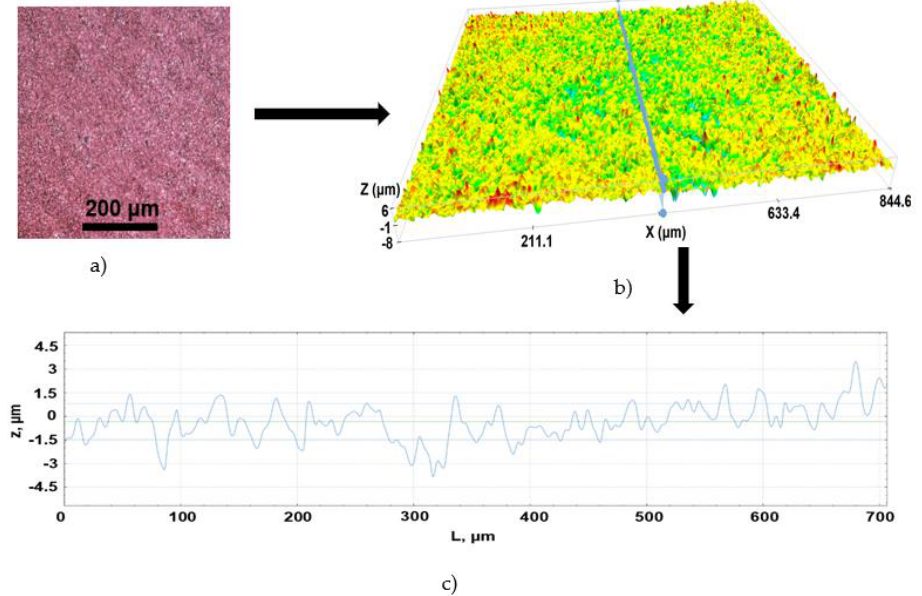
Figure 13. ( a ) Homogeneous copper layer plated on the LIG surface (magnified x10). ( b ) 3D optical profilometer image of copper-plated sample surface topography and the line shows 2D surface to- pography along the middle of the image ( c